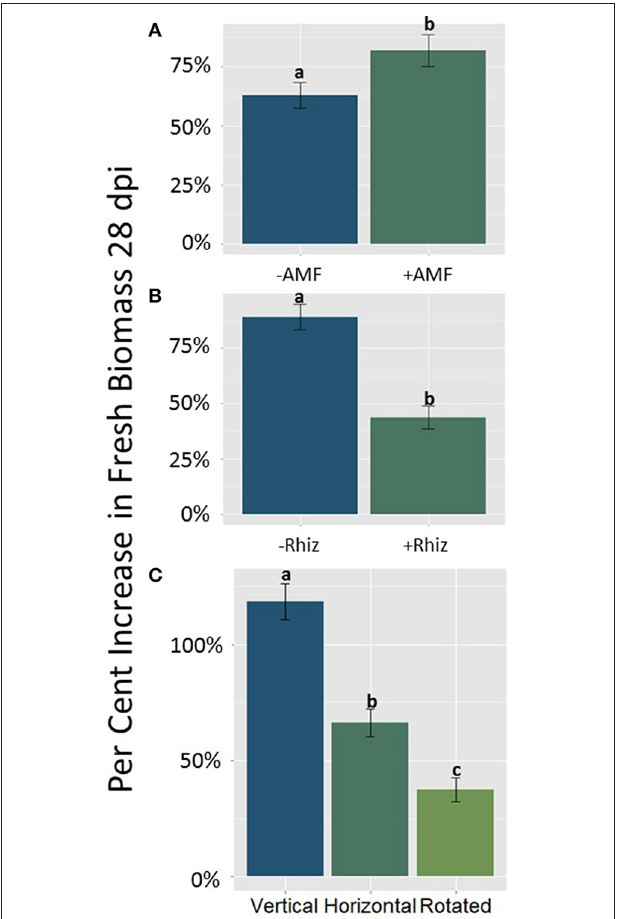
FIGURE 3 | (A–C) The main effects of AMF (A) , rhizobia (B) , and gravitational treatment (C) on the difference in fresh mass of seedlings 28 days post inoculation (dpi) in the host, M. truncatula . (A) AMF treated plants from all three orientations ( n = 94 ) gained significantly more fresh mass compared to plants not treated with AMF ( p < 0.05 ). (B) Rhizobia treated plants from all three orientations ( n = 69 ) gained significantly less fresh mass compared to plants not treated with rhizobia ( p < 0.05 ). (C) The clinorotated plants ( n = 66 ) gained less fresh mass compared to vertically and horizontally grown plants ( p < 0.05 ; n = 58 and n = 62 , respectively). The letters above each standard error bar denote significance between treatments.